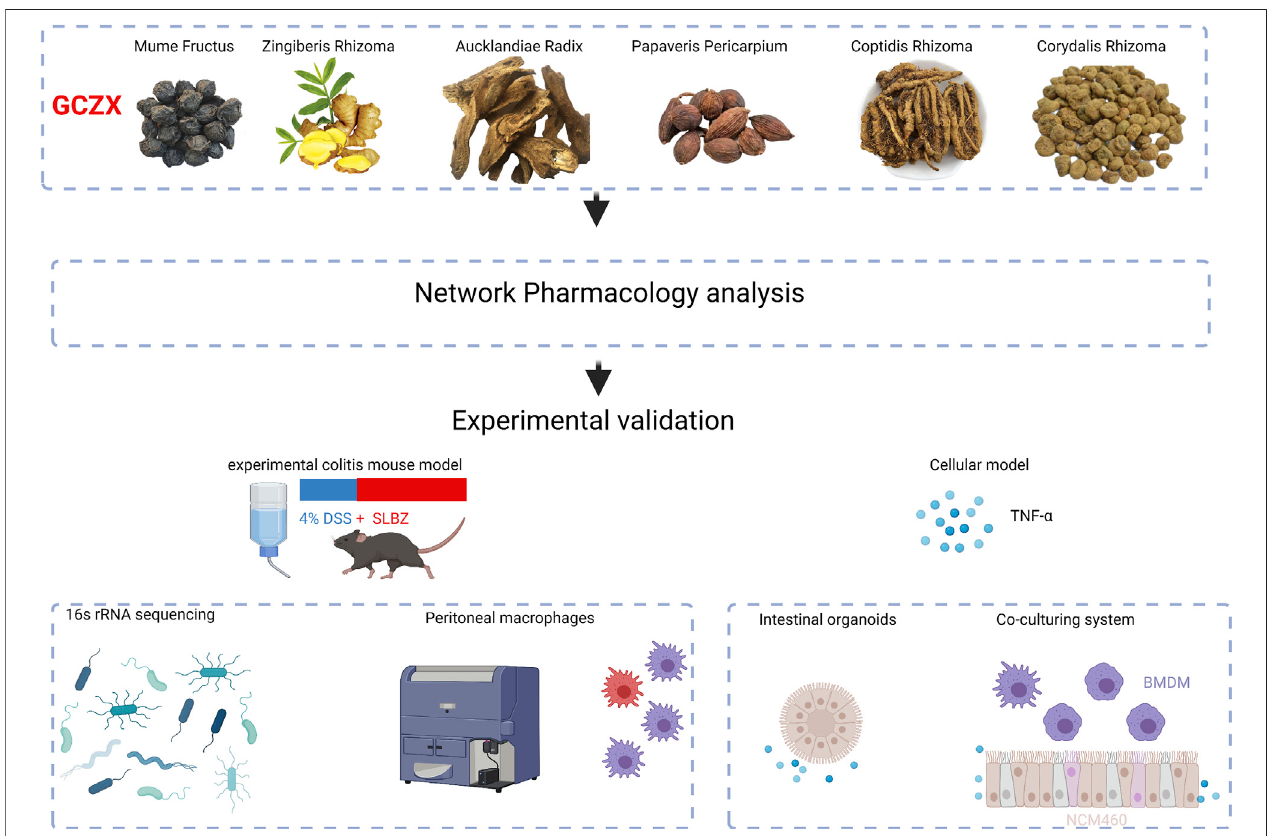
FIGURE 10 | Shematic fl ow of the present